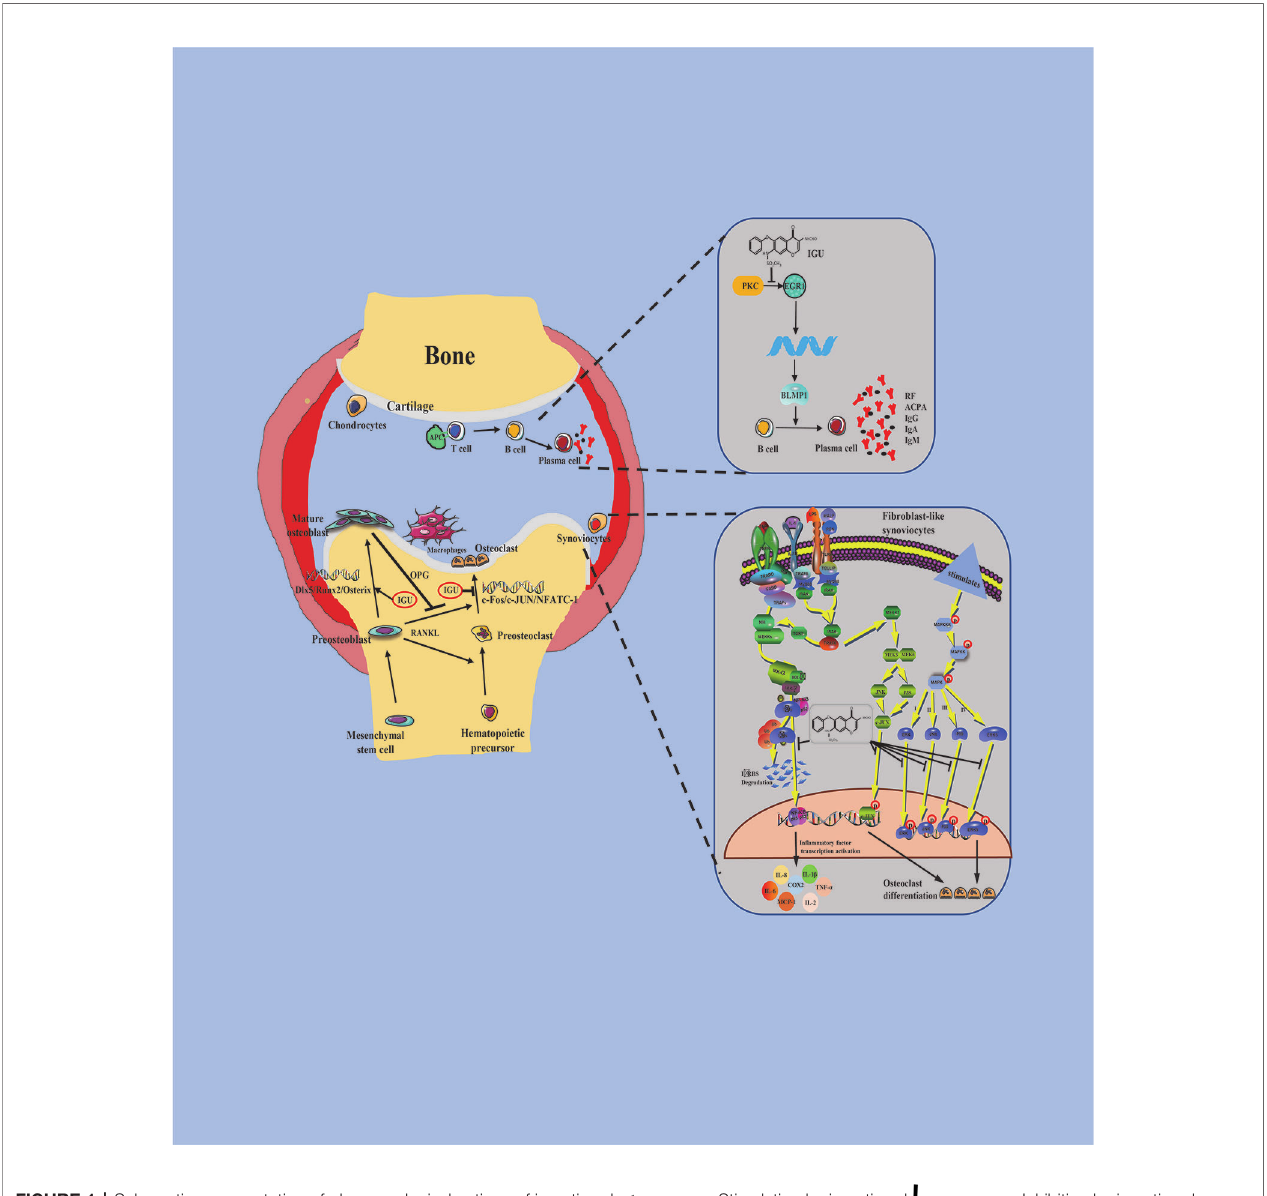
FIGURE 1 | Schematic representation of pharmacological actions of iguratimod. Stimulation by iguratimod Inhibition by